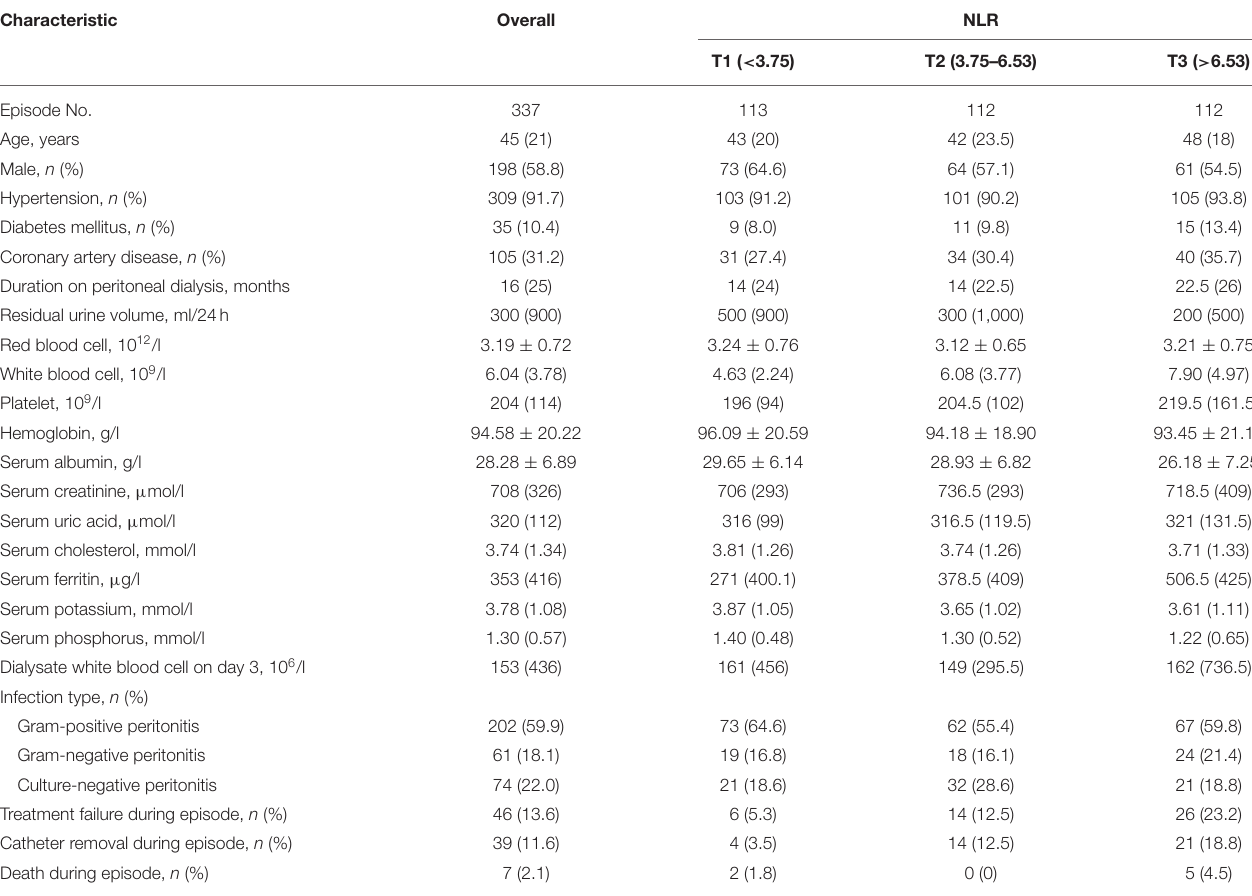
TABLE 1 | Clinical characteristics of peritonitis episodes by NLR groups. Characteristic